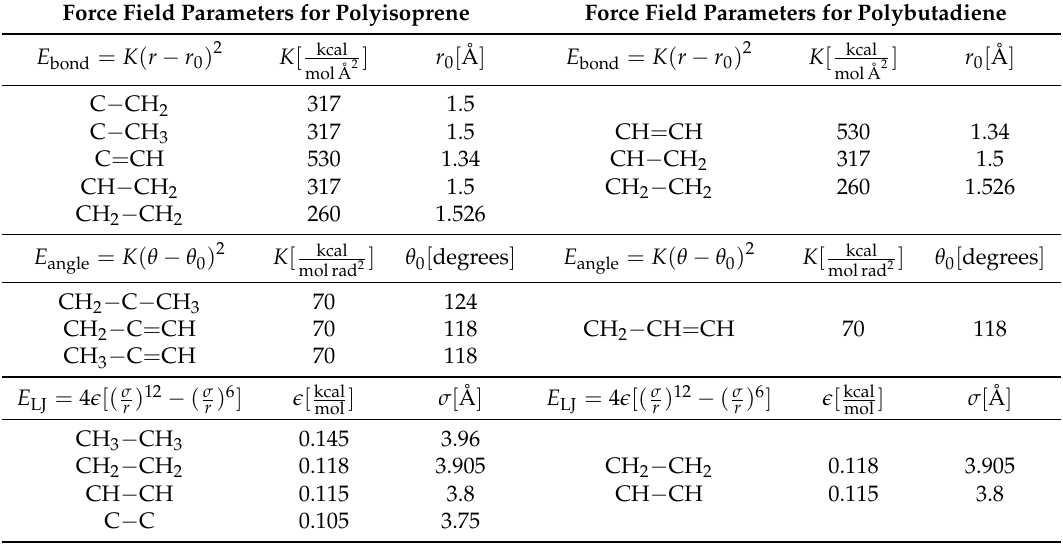
Table 1. Force field parameters used in MD simulations. Usual factor of 1/2 in stretching and bending interactions is included in K . Force Field Parameters for Polyisoprene Force Field Parameters for